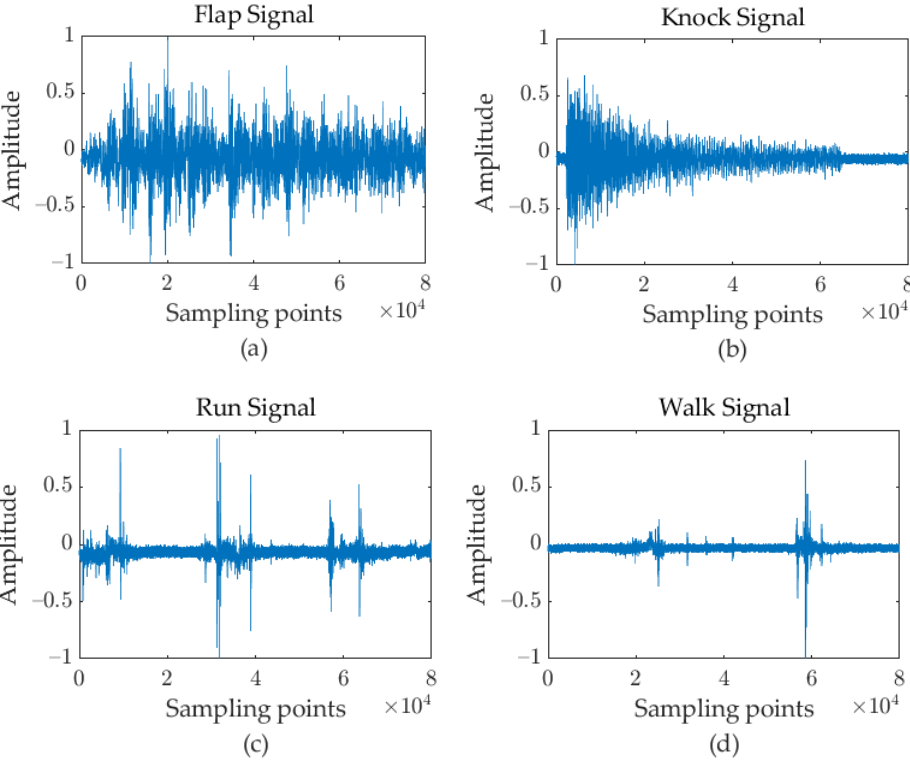
Figure 6. Four kinds of fiber vibration signals after pretreatment: ( a ) flap signal, ( b ) knock signal, ( c ) run signal; ( d ) walk signal.